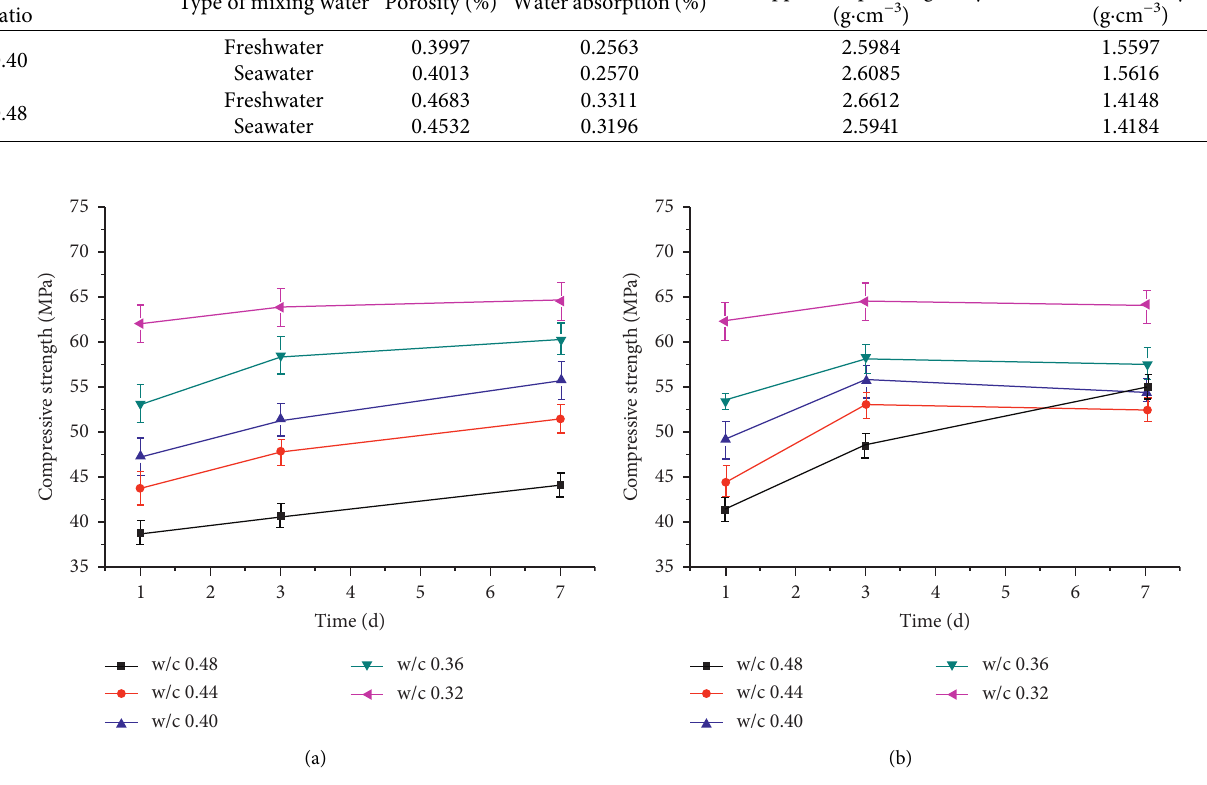
Table 4: The physical properties of CSA paste with different w/c ratios and mixing water. Water-cement